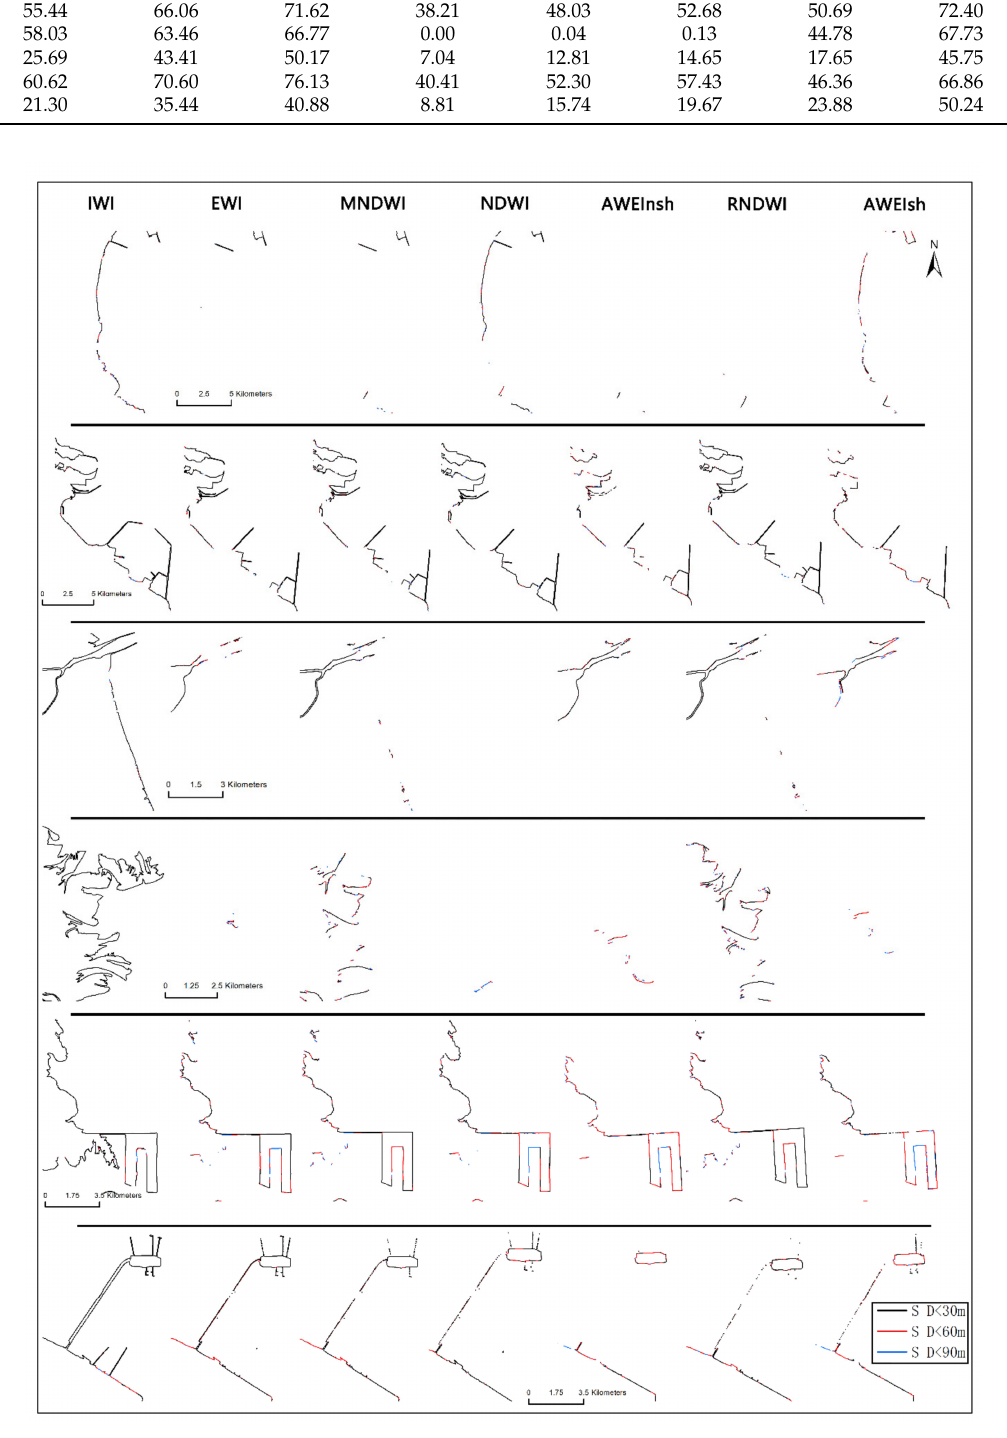
Figure 6. Image of shoreline local validation results, in descending order of dimensionality. The leg- end S D (coastline distance) indicates the distance between the extracted coastline and the validation coastline; black, red and blue represent the different validated coastline